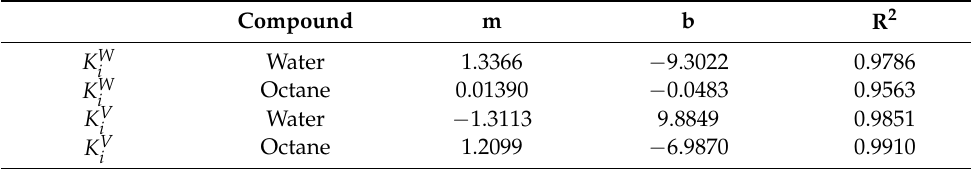
Table 7. Constants for K-value correlation of water/n-octane system.